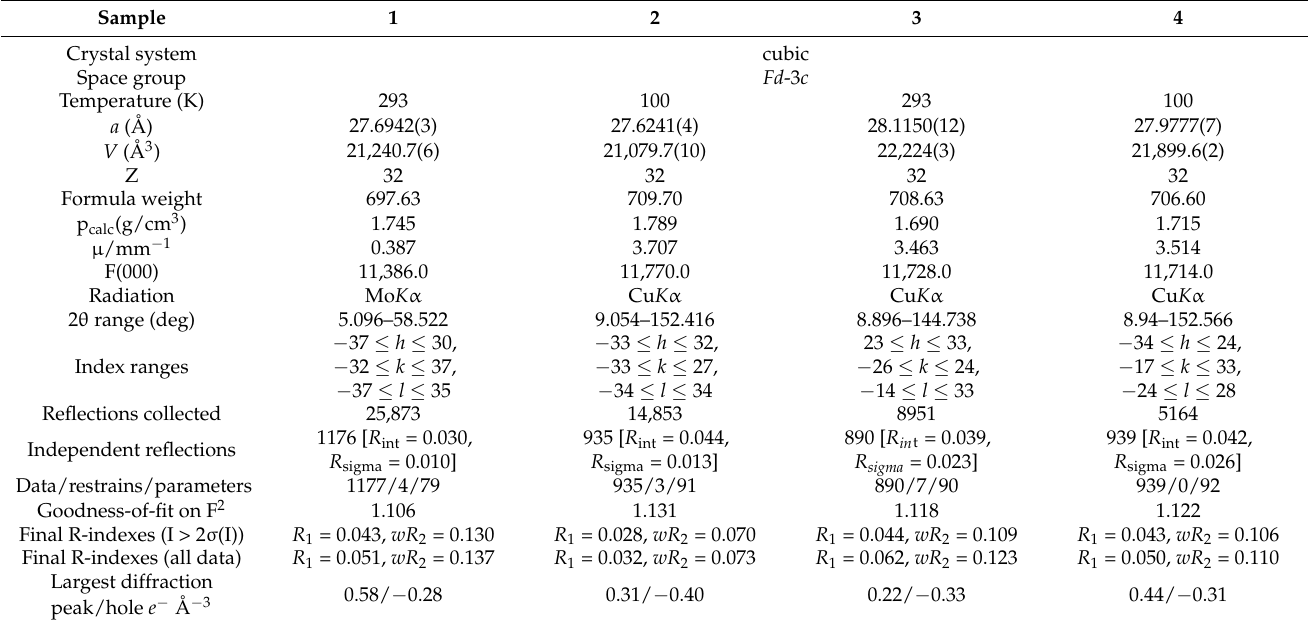
Table 1. Crystal data and refinement parameters for natrophosphate (1—room temperature (RT), 2—100 K) and its synthetic analogue (3—RT, 4—100